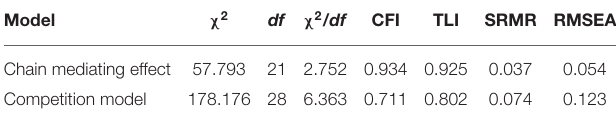
TABLE 6 | Test of competition model of mediating